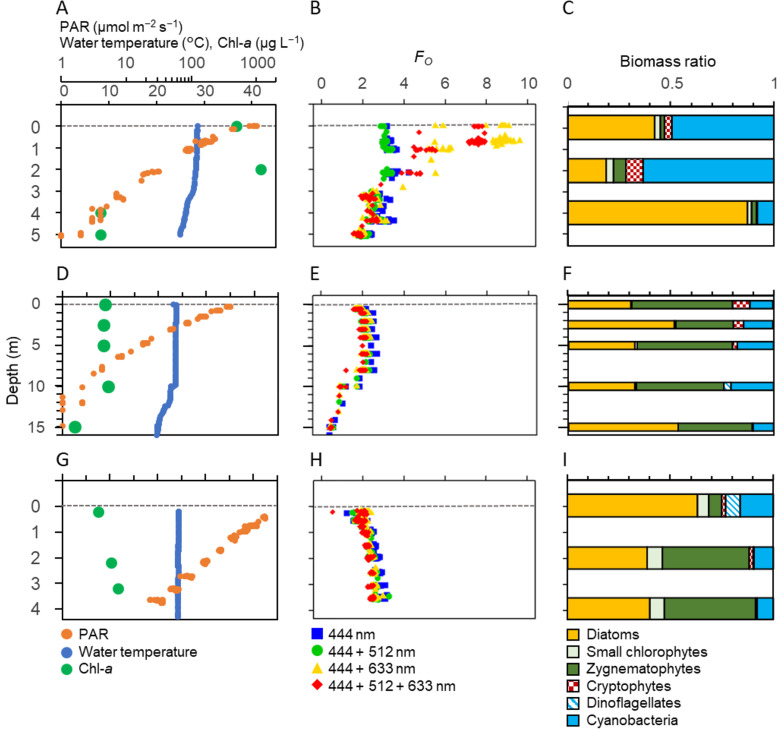
Comparison of vertical profiles of PAR, water temperature, Chl-a, Fo and phytoplankton biomass ratios during cyanobacterial blooms and at other times.Panels showing PAR, water temperature, Chl-a (A, D, G), Fo (B, E, H) estimated by different combinations of excitation wavelength from the FRRf, and phytoplankton biomass (C, F, I) at Station 9B on 28th August (A, B, C), Station 12B on 13th September (D, E, F) and Station 6B on 18th September 2018 (G, H, I). Grey dashed lines denote 0 m.